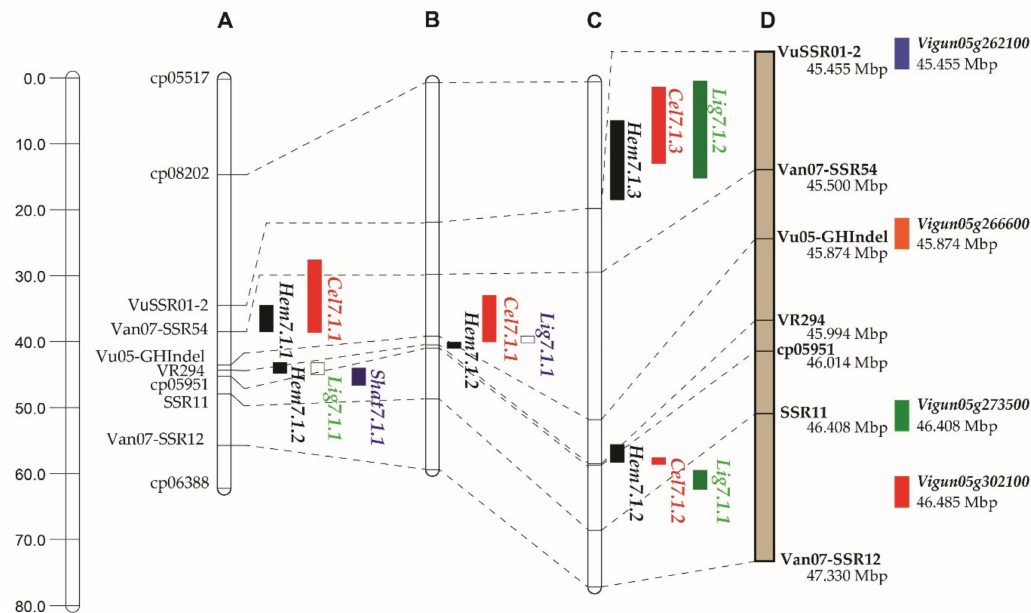
Figure 3. Location of QTLs for cellulose, hemicellulose, and lignin contents in pod and pod shattering identified on linkage group 7 of populations F2A ( A ), F2B ( B ) and F2C ( C ) derived from a cross between JP81610 (yardlong bean) and TVnu-457 (wild cowpea) (see Materials and Methods Section for